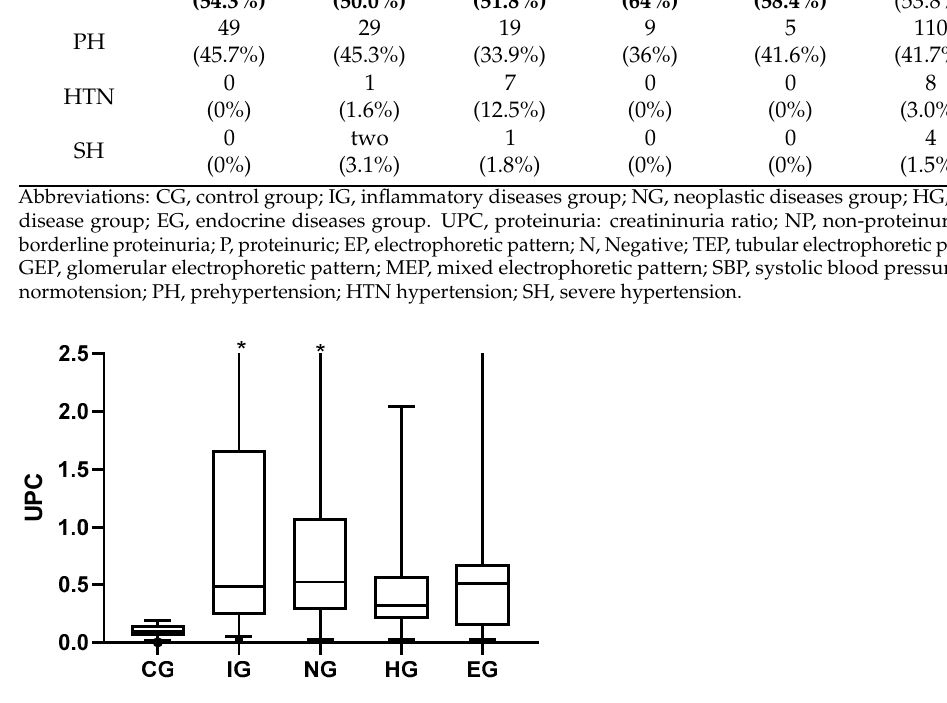
Figure 2. UPC values for the different groups of pathologies. Minimum, maximum, and quartile 1 and 3 in the scatter box plot. Abbreviations: CG, control group; IG, inflammatory diseases group; NG, neoplastic diseases group; HG, heart disease group; EG, endocrine disease group. The asterisks are values outside the scale established for the table multiplied by three.